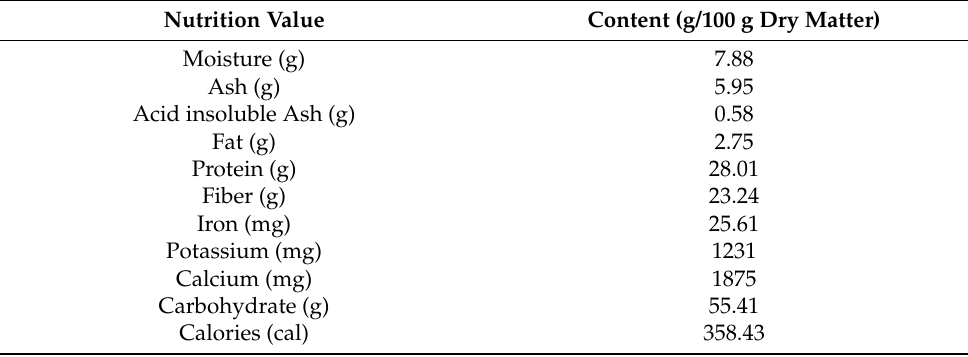
Table 1. Chemical composition of Moringa oleifera leaf flour.